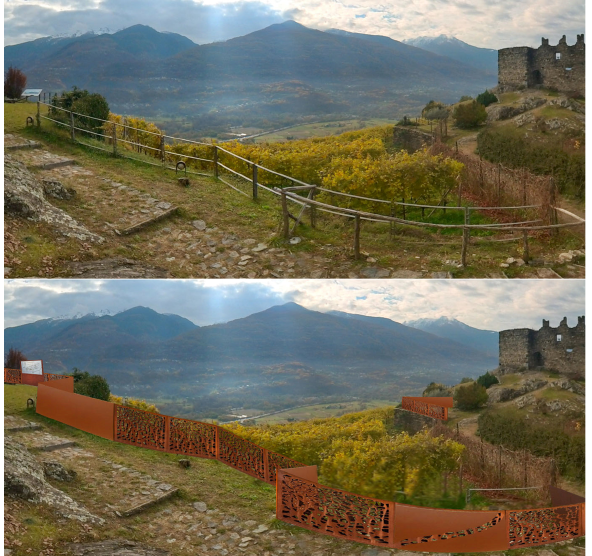
Figure 7: A detail extracted from the previous image. As can be seen, straight lines become curved elements in the equirectangu- lar projection, making direct rendering of such images a compli- cated task.